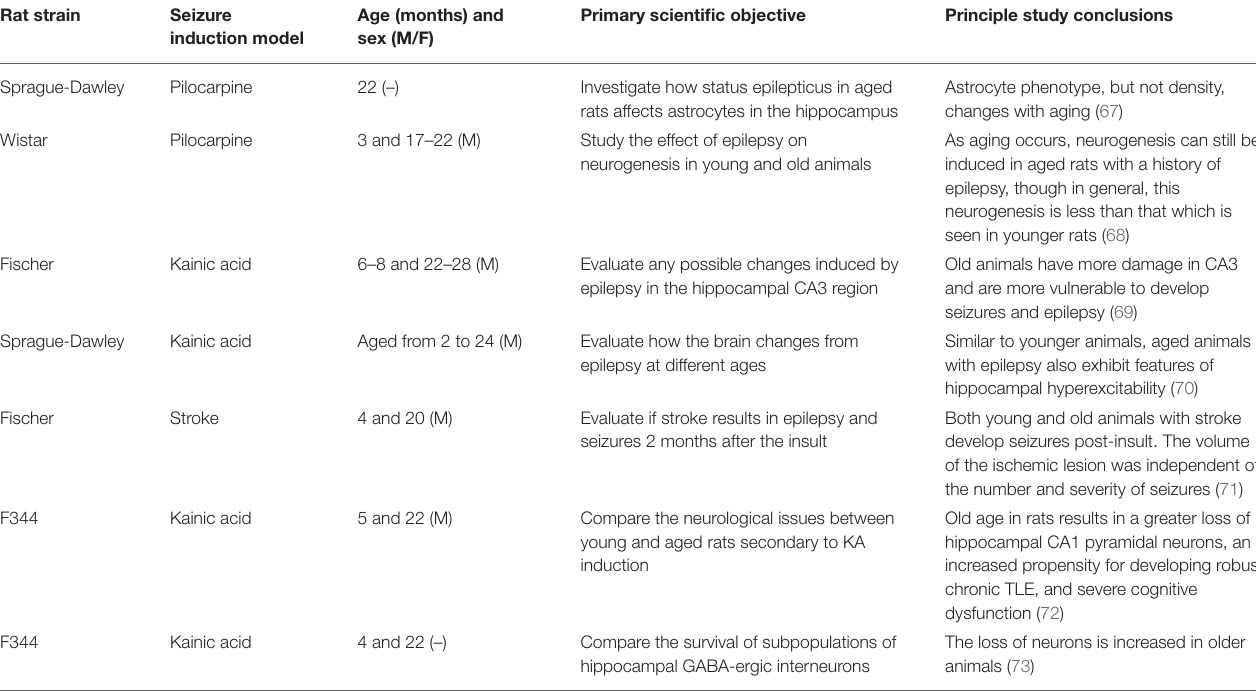
TABLE 2 | Primary pre-clinical studies of epilepsy in aged